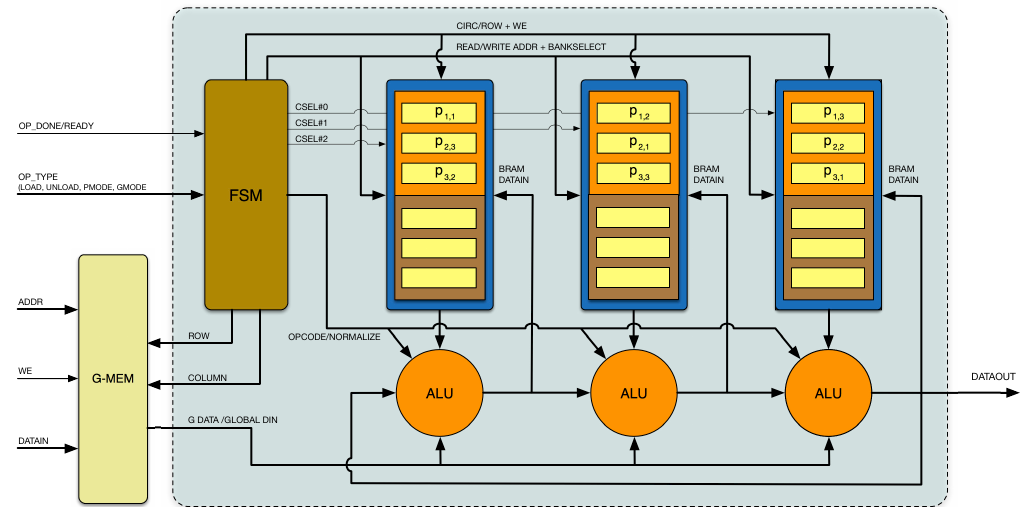
Figure 2. Hardware computation structure for matrix arithmetic operations. ALU-RAM blocks (shown in columns) are chained for iterated computational the FSM controls the data flow where one matrix operand is stored in RAM blocks and the second operand, either matrix, vector or scalar, is externally fed from a memory (G-mem) or any other external